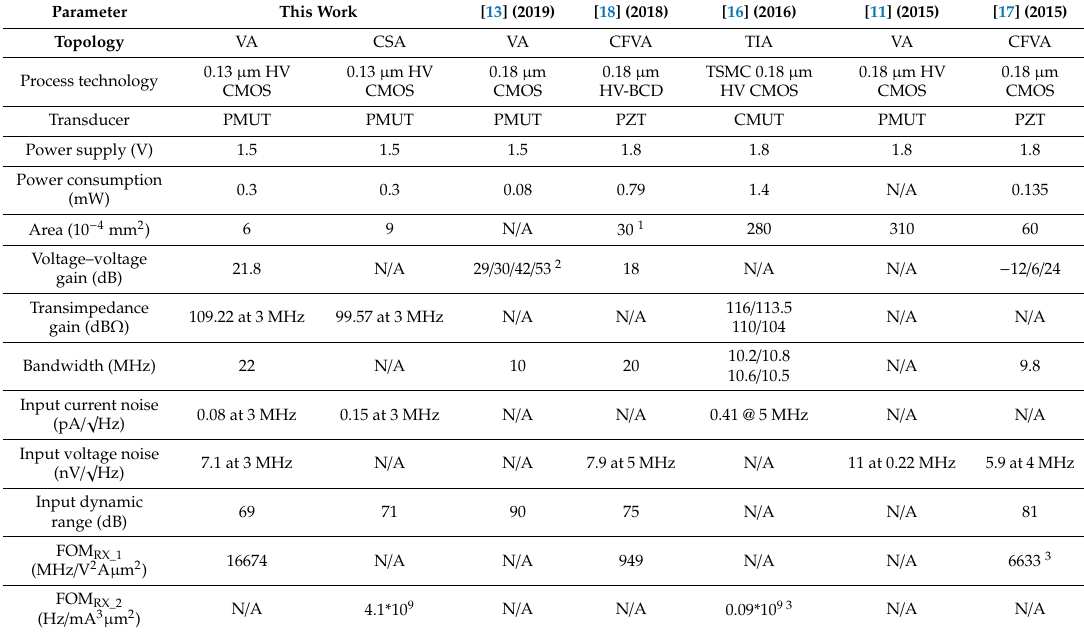
Table 3. Measured LNA performance summary and